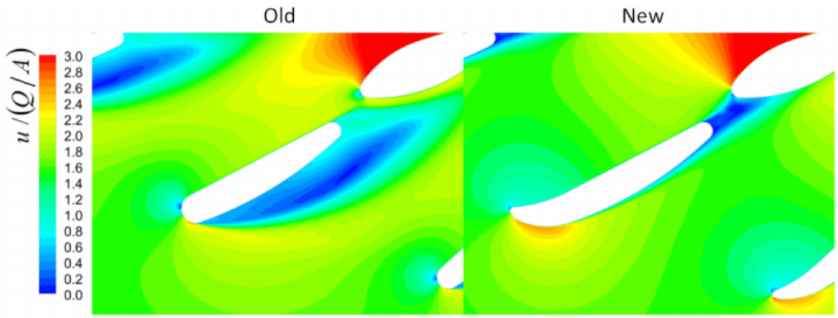
Figure 11. Velocity at the tandem cascade horizontal plane in case 2 hydraulic turbine functions of the inlet area of the spiral case and the turbine discharge.